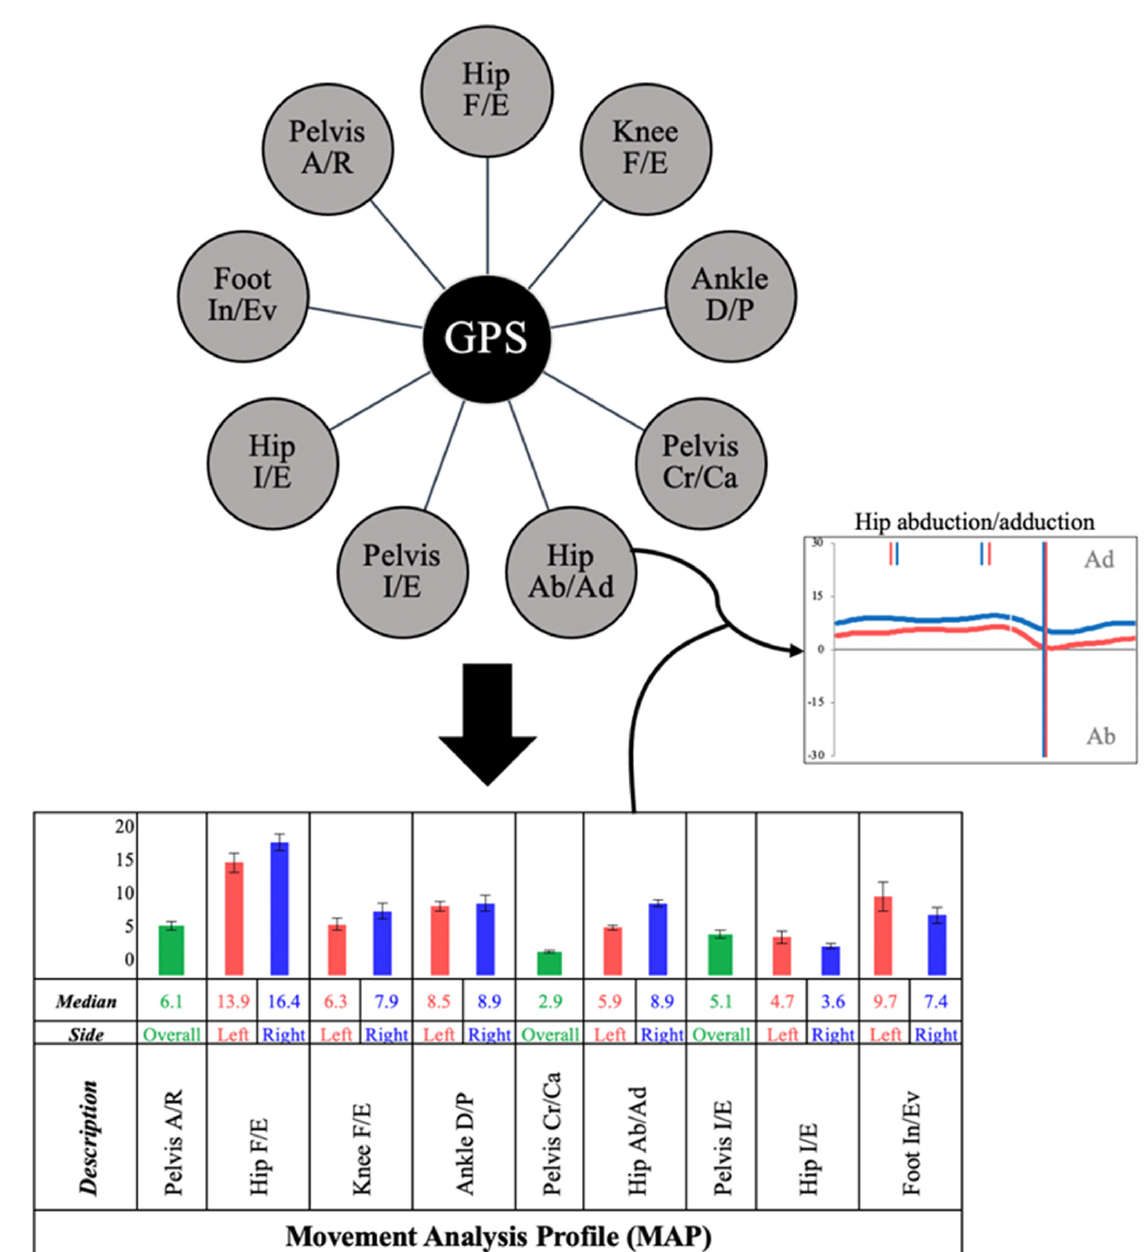
Figure 3. Diagram of the Gait Profile Score (GPS), which is formed of nine Gait Variable Scores (GVS), which generate a Movement Analysis Profile (MAP) of an individual patient. Individual GVS parameters can then be analyzed in detail using motion graphs (for example hip abduction/adduction as shown above). Table 3. Kinematic angular gait parameters of both limbs.